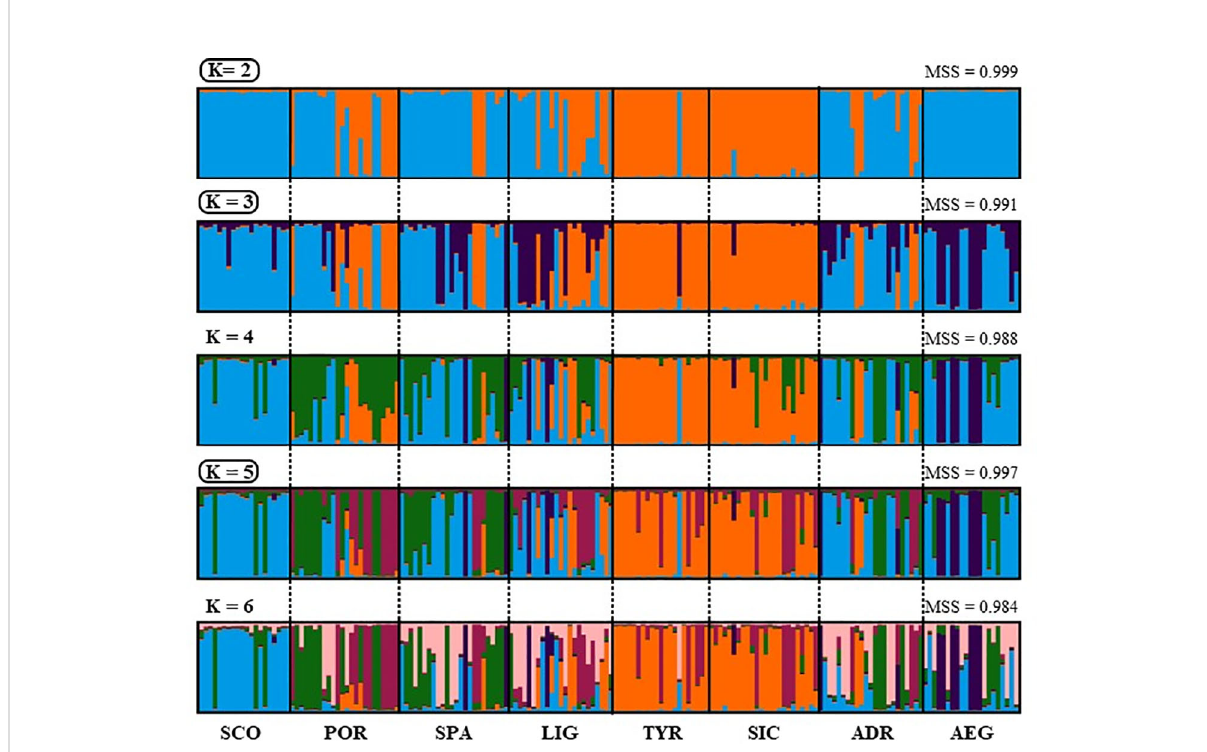
FIGURE 3 Bayesian clustering barplot showing membership probabilities (q) for each individual after CLUMPAK analysis, see Table 1 for geographical location codes. For each K analysed the mean similarity score (MSS) is